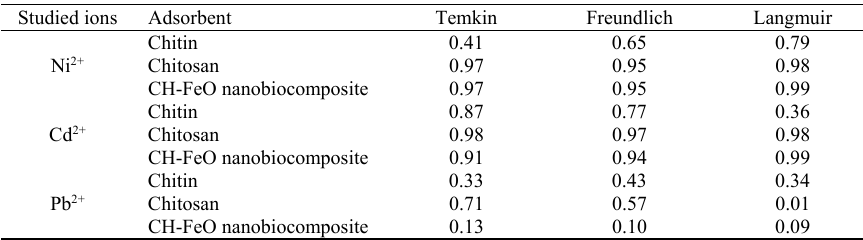
Table 2: The R 2 values in study adsorption isotherms